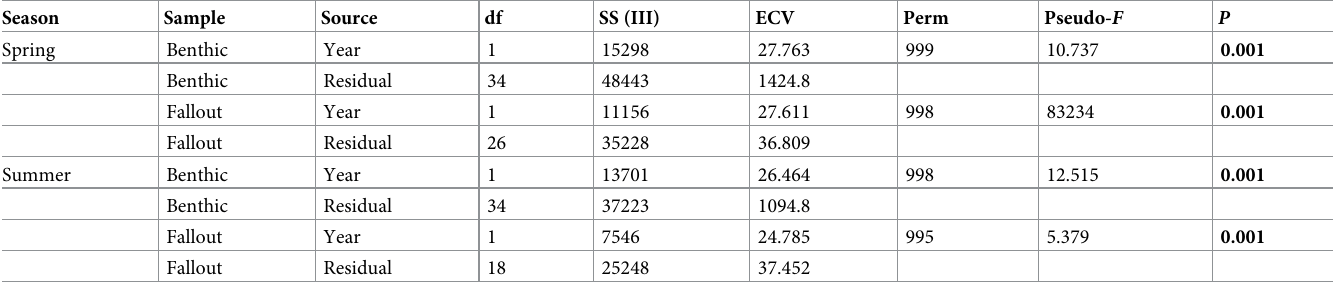
arachnids, crustaceans, collembola, molluscs, worms, myriapoda, and hydrozoa. Although the Table 3. PERMANOVA results for main test of year effect on estuary benthic and fallout invertebrates. Season